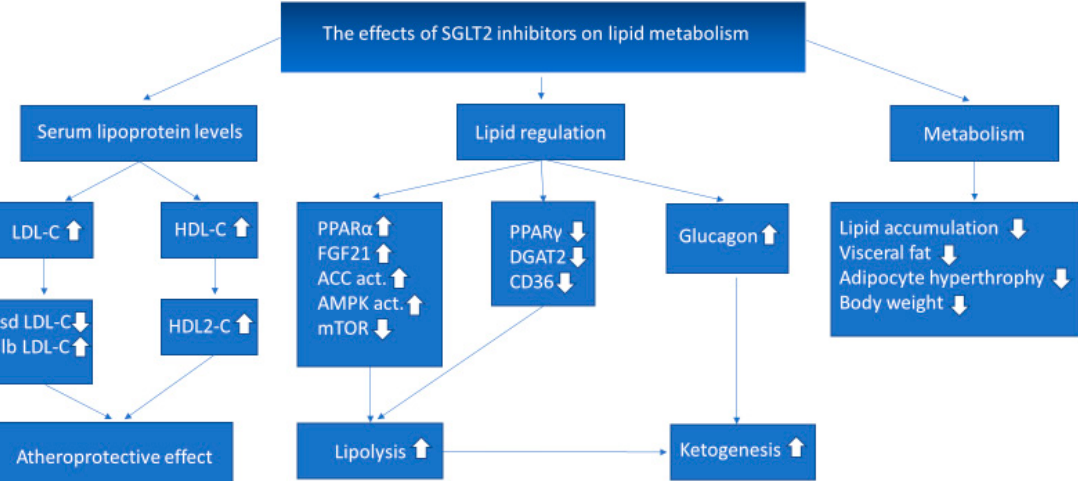
Figure 2. The effects of SGLT2 inhibitor therapy on lipid metabolism. LDL-C: low density lipoprotein cholesterol; sd LDL-C: small dense low-density lipoprotein cholesterol; lb LDL-C: large buoyant low-density lipoprotein cholesterol; HDL-C: high-density lipoprotein cholesterol; PPAR α : peroxisome proliferator-activated receptor α ; FGF21: fibroblast growth factor 21; ACC act.: acetyl-CoA carboxylase activation; AMPK act.: AMP-activated protein kinase activation; mTOR: mammalian target of rapamycin; PPAR γ : peroxisome proliferator-activated receptor γ ; DGAT2: diacylglycerol O-acyltransferase 2; CD36: cluster of differentiation 36; ↑ : increased amount; ↓ : decreased amount.